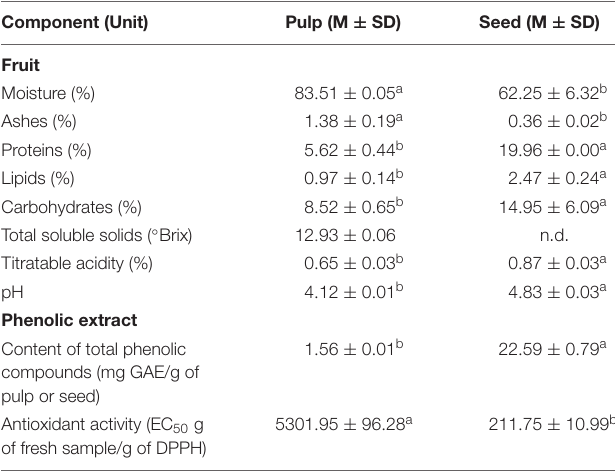
TABLE 1 | Centesimal composition, physicochemical characteristics, content of total phenolic compounds, and antioxidant activity of the pulp and seed of S. cumini (L.)